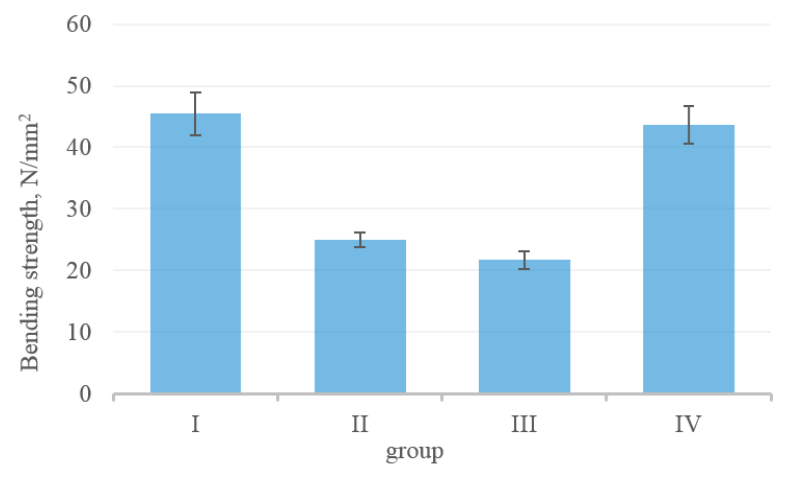
Figure 8. Bending strength results when specimens were soaked in different ways. Table 3. Tensile test results for LVL